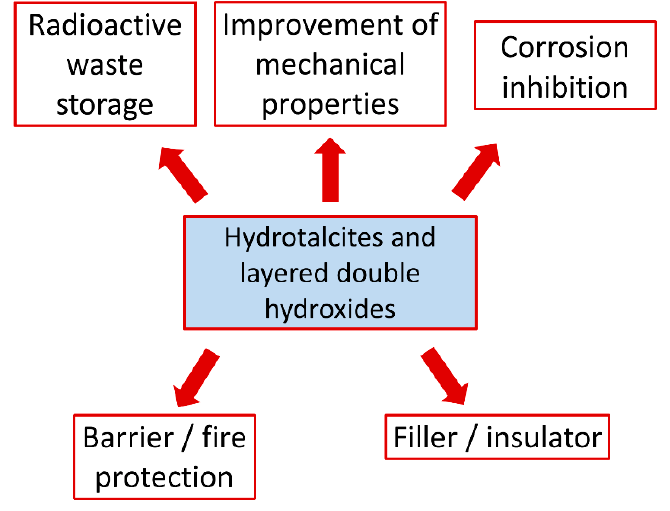
Figure 3. Scheme of application of hydrotalcites in building materials.